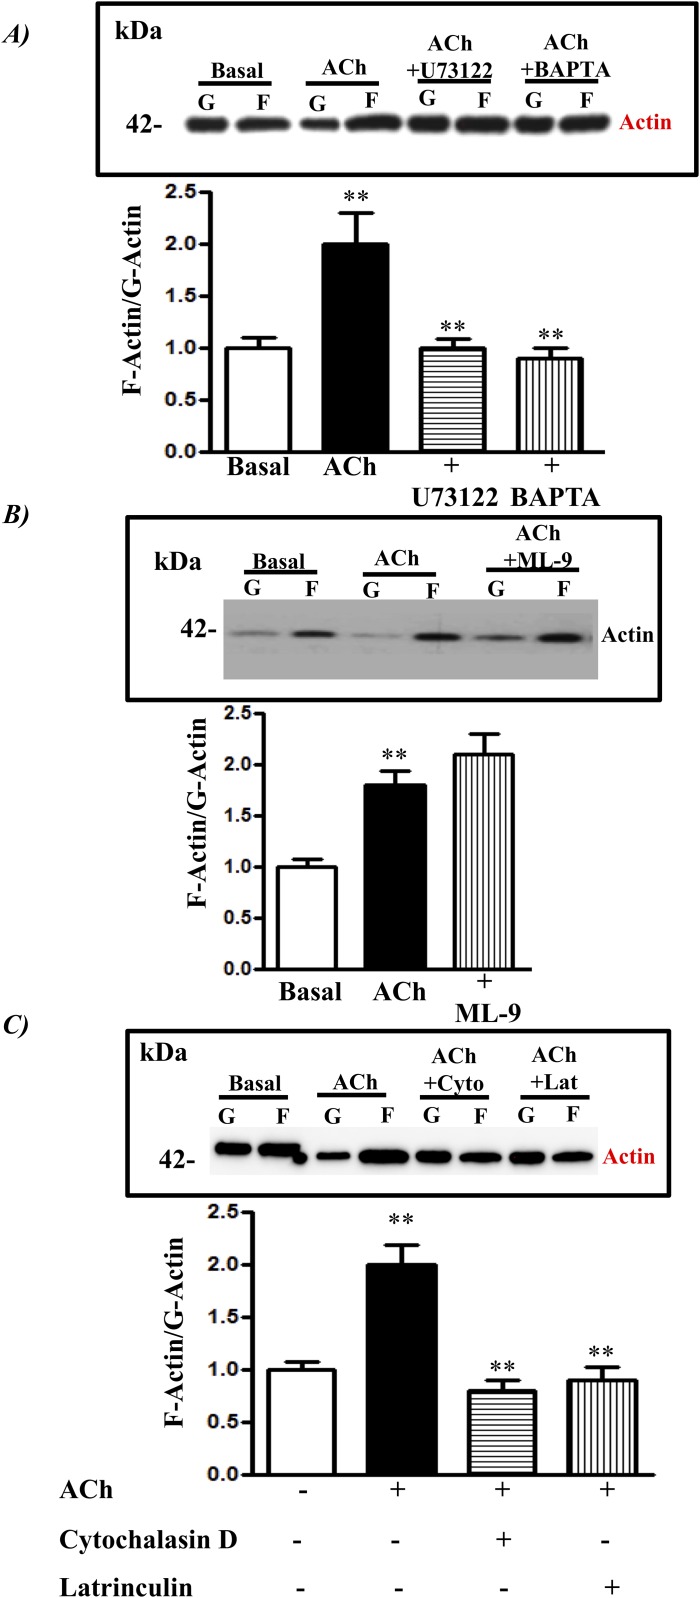
Increase in initial actin polymerization by ACh.The initial actin polymerization (F-actin to G-actin) was measured by Western blot using actin antibody in the pre-treatment of cultured smooth muscle cells with PLC inhibitor U73122 (10 μM, 10 min) and, Ca2+ Chelator BAPTA (1 μM, 10 min) (A); and the MLCK inhibitor ML-9 (1 μM, 10 min) (B); and actin polymerization inhibitors (cytochalasin D, 10 μM; latrunculin, 1 μM 1 h) (C), followed by 1 μM ACh for 1 min. The results are expressed as densitometric values. Values are means ± SE of seven experiments. **P<0.001.